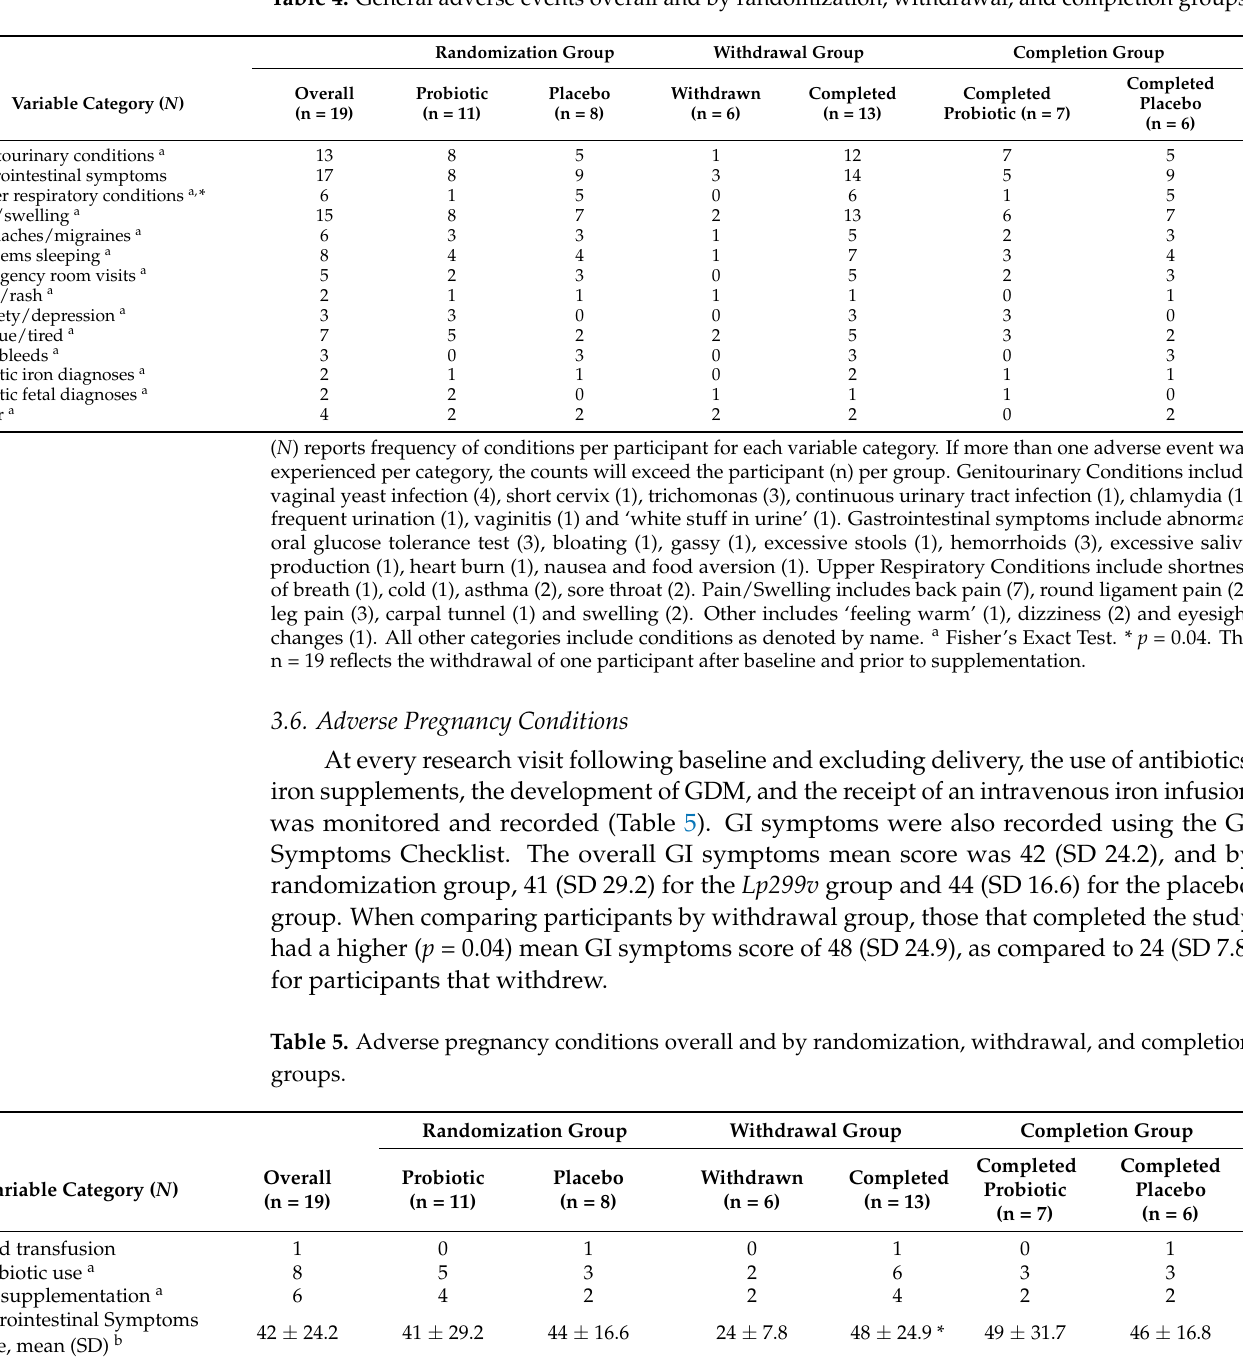
Table 4. General adverse events overall and by randomization, withdrawal, and completion groups.